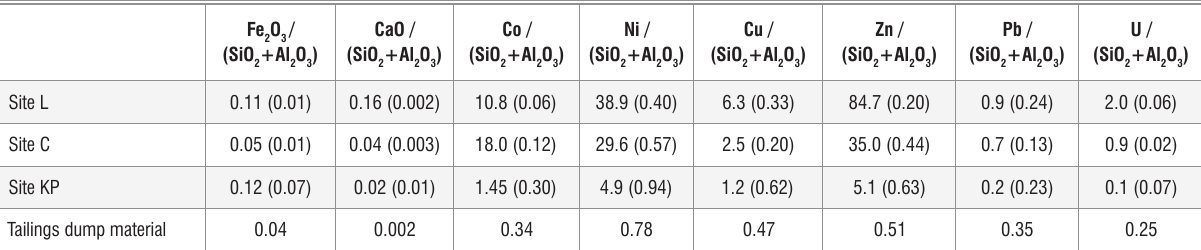
Figure 6: Normalised metal concentration profiles of peat samples from (a) Site L, (b) Site C and (c) Site KB. Table 2: Average normalised metal ratios within tailings dump material and the inorganic fraction of peat deposits at Sites L, C (this study) and KP. 17 Normalised metal ratios in the clastic layer underlying the peat are given in